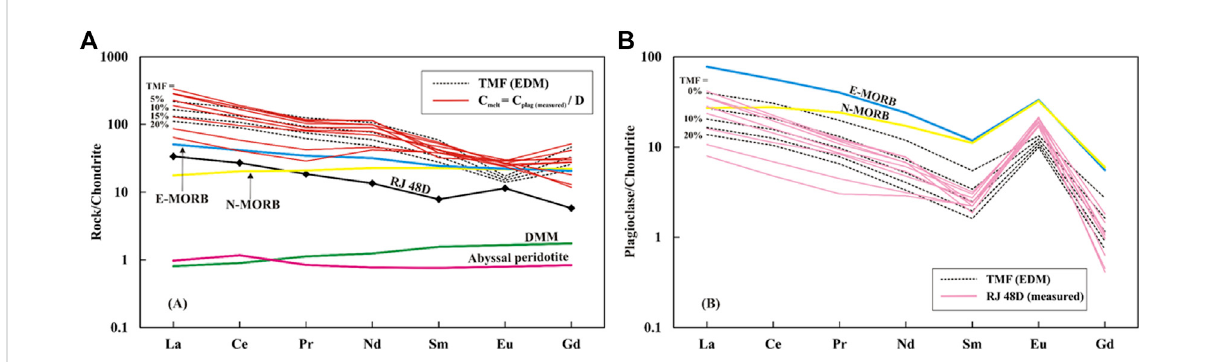
FIGURE 11 Chondrite normalized rare earth element patterns for (A) whole rock and (B) plagioclase for anorthosite sample RJ 48D from the study area of ChotanagpurGraniteGneissComplex.Trappedmeltfractionsat0,5,10,15,and20%havebeencalculatedusingtheequilibriumdistributionmethod (EDM) of Bédard (1994, 2001). Partition coef fi cient (D) values are taken from Bédard (2001). See text for details. In whole rock, enriched-MORB 9(E-MORB) and normal-MORB (N-MORB) values are taken from Gale et al. (2013), whereas DMM and abyssal peridotite values are taken as in Figure8.Inplagioclase,E-MORBandN-MORBvaluesarecalculatedviaequilibriumdistributionmethodusingwhole-rockmajor(tocalculatemodal abundance) and rare earth element compositions from Gale et al. (2013). Normalizing values are the same as in Figure